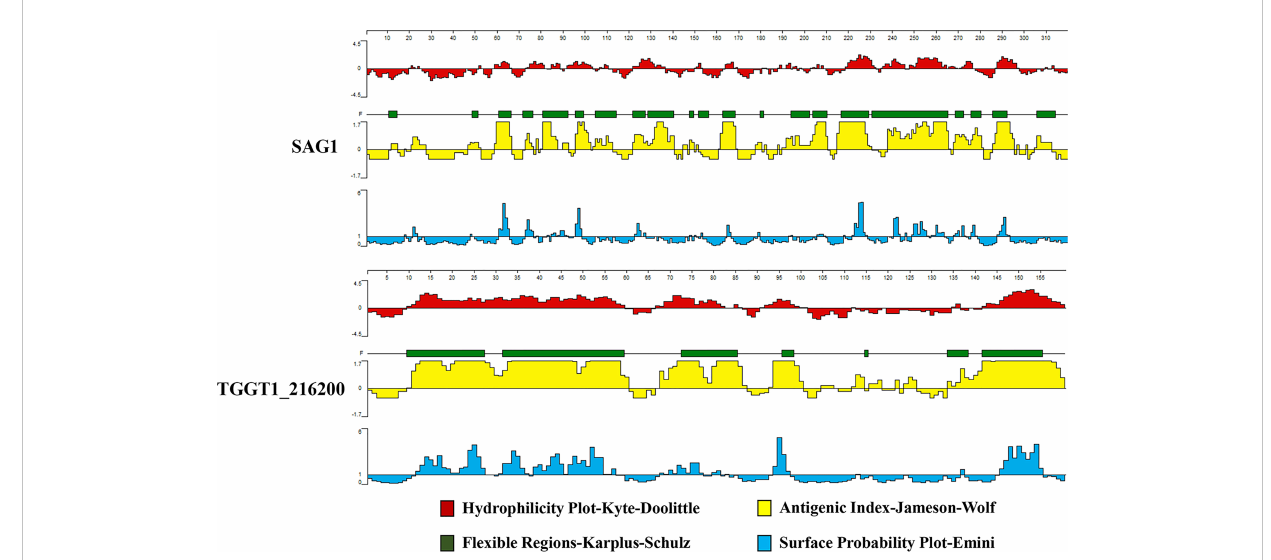
FIGURE 2 The plot of the DNASTAR-predicted hydrophilicity, fl exible regions, antigenic index, and surface probability of the linear-B cell epitopes of TG_200 compared with those of